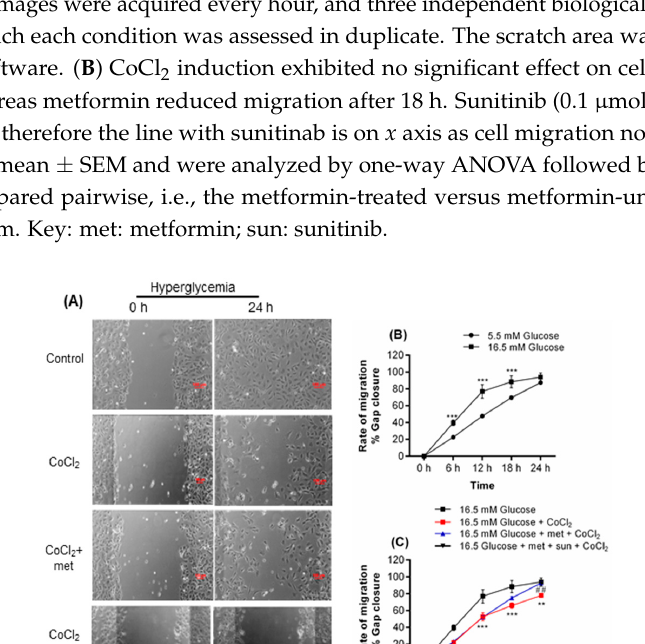
Figure 2. Metformin improves cell migration in HUVEC exposed to hyperglycemia and CoCl 2 . ( A ) HUVEC were incubated for 24 h with hyperglycemia in the presence or absence of metformin. Scratch lines were created on confluent monolayers. The media containing different glucose concentrations and metformin were replaced. Then cells were incubated with CoCl 2 for 24 h in a 5% CO 2 chamber that was connected to CCD camera. Images were acquired every hour, and three independent biological experiments were performed at which each condition was assessed in duplicate. The scratch area was measured using NIS Elements software. ( B ) Hyperglycemia increased migration after 6, 12, and 18 h; ( C ) whereas hyperglycemia-CoCl 2 significantly reduced migration. Metformin increased cell migration under hyperglycemia-CoCl 2 . Sunitinib was used as a negative control, therefore the line with sunitinab is on x axis as cell migration not affected. Results are expressed as mean ± SEM and were analyzed by one-way ANOVA followed by LSD, ** p < 0.01, *** p < 0.001 compared to the control. ## p < 0.01, ### p < 0.001 compared pairwise, i.e., the metformin-treated versus metformin-untreated condition. Scale bar is 100 µm. Key: met: metformin; sun: sunitinib.